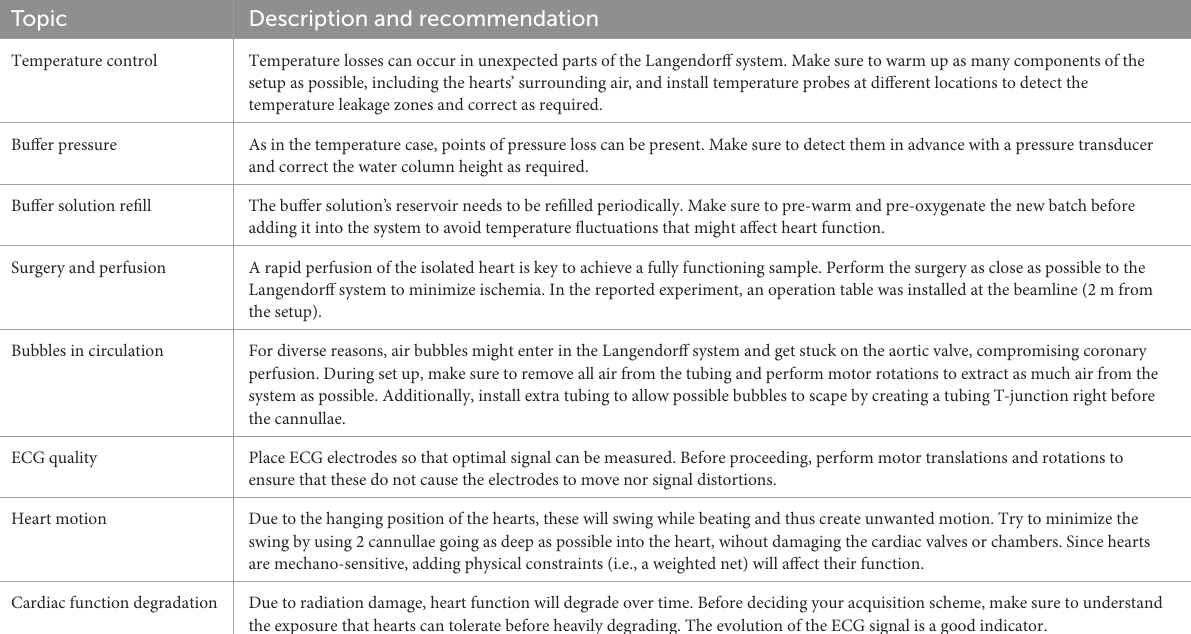
TABLE 3 Summary of experimental considerations and corresponding recommendations. Topic Description and recommendation Temperature